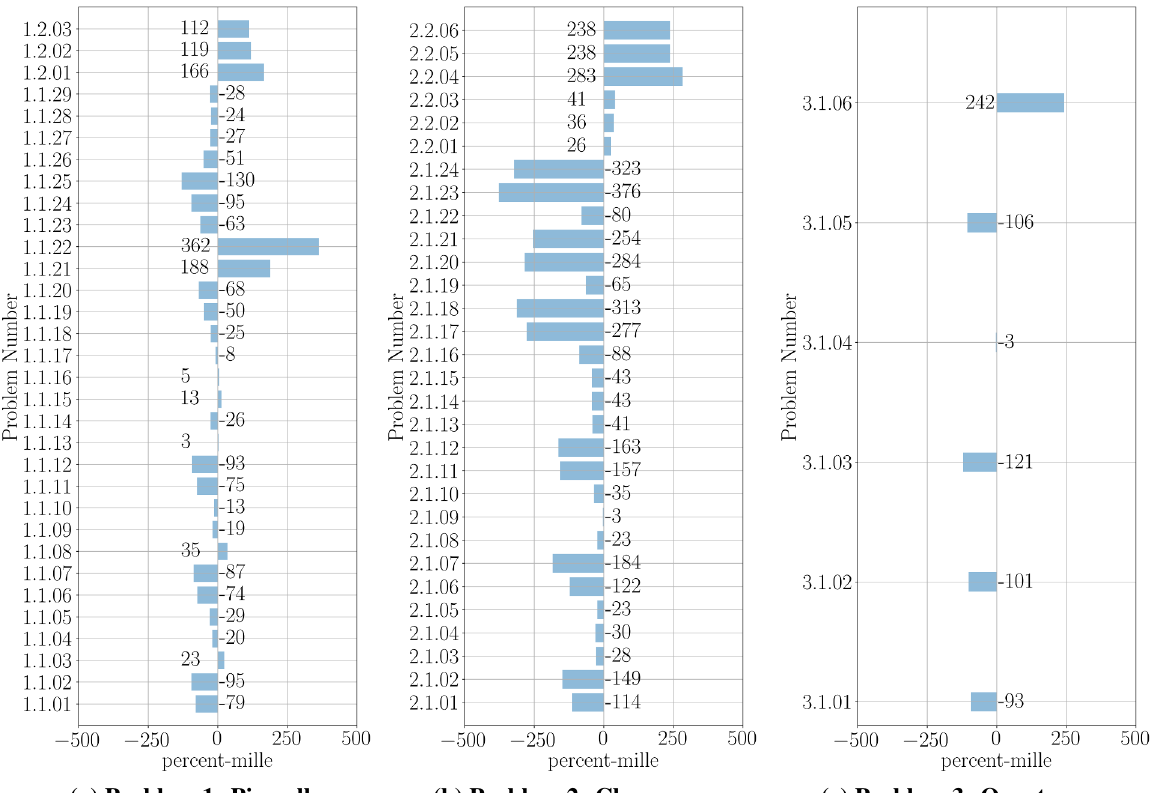
Figure 2: Comparison of k